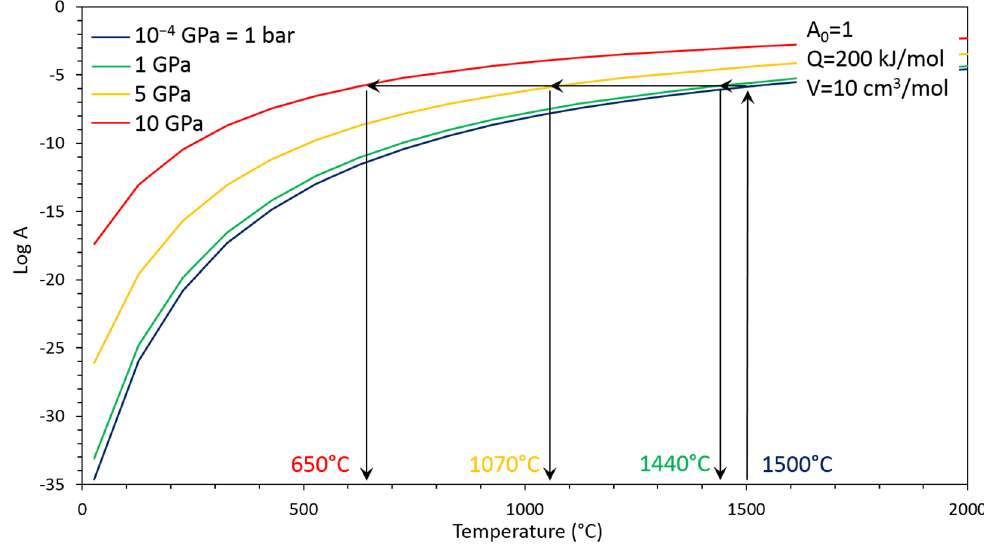
Figure 2. Graphic illustration of Equation (1) showing the efficiency of pressure (colored curves) to activate a physical or chemical process A as a function of temperature. Starting parameters A 0 , Q and V have been chosen arbitrary for illustration purposes. Sintering can be activated at several hundred degrees lower when applying high pressure of few GPa than at 1 bar ( 10 − 4 GPa ).